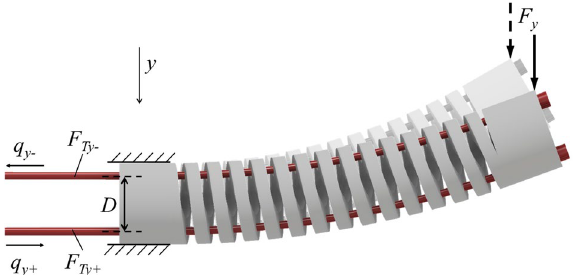
Figure 1. Tendon-driven helical continuum manipulator subjected to a unidirectional contact force F y